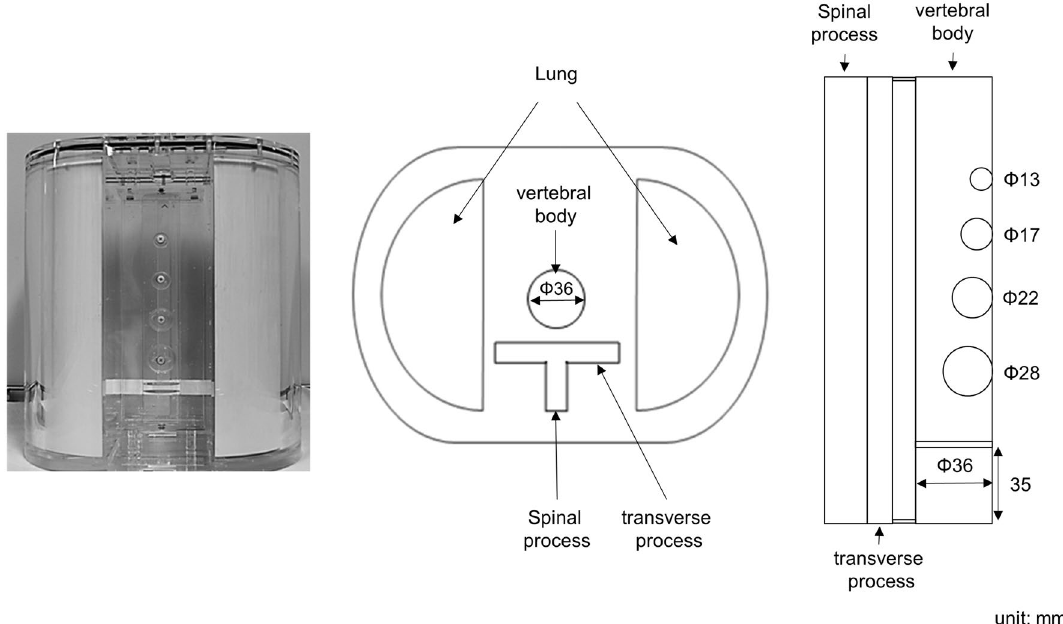
Figure 1. An overview of Sim 2 Bone phantom. The left image shows the appearance of the phantom. The middle and right diagrams show the schemes of transverse and lateral